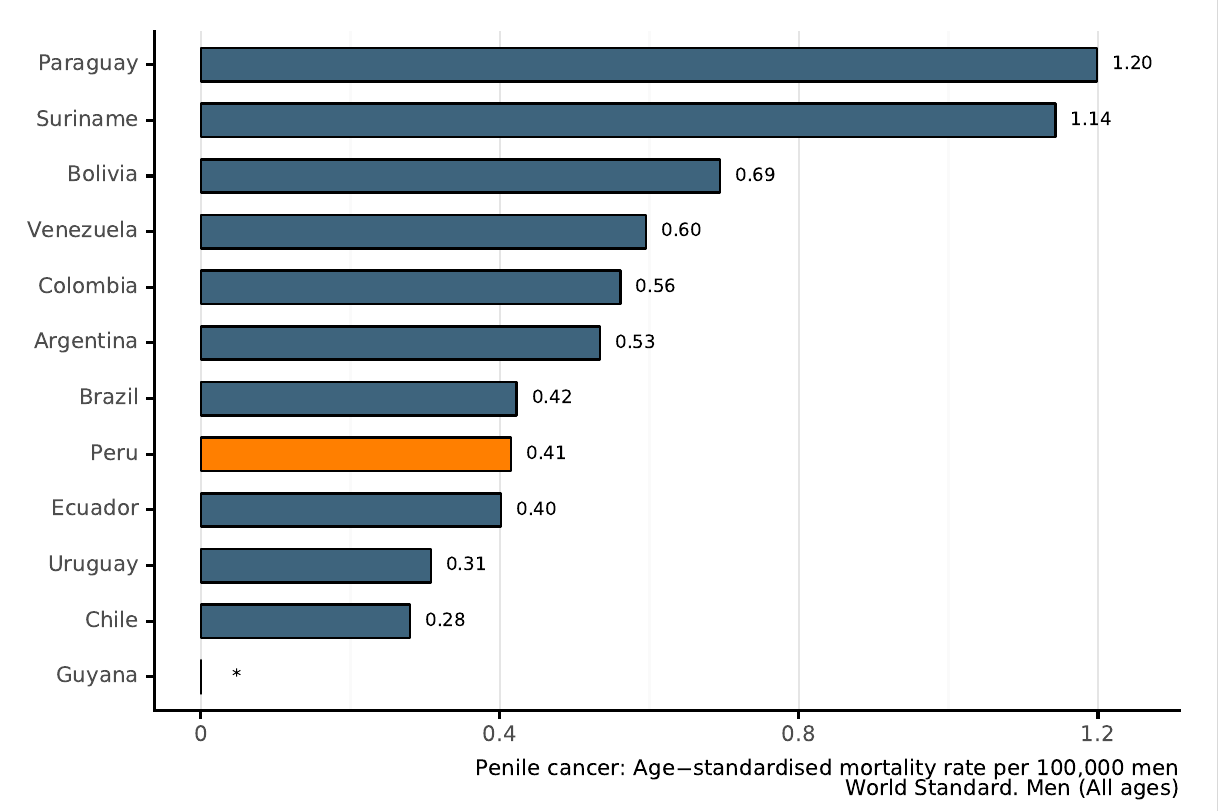
Figure 119: Age-standardised mortality rates of penile cancer of Peru (estimates for 2020)